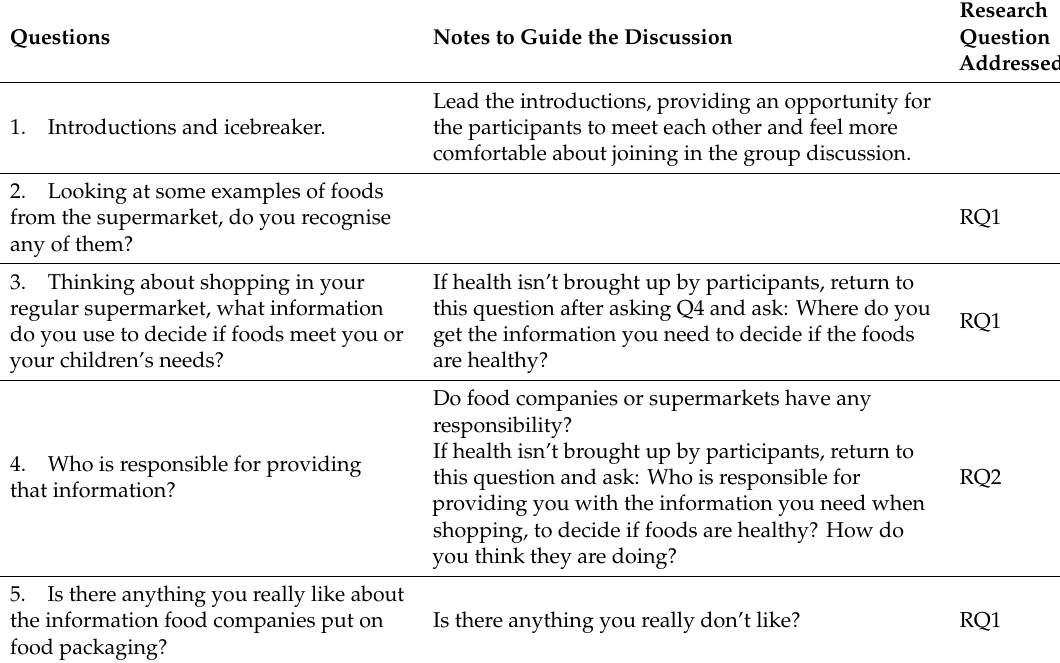
Table 3. Questions used to promote focus group